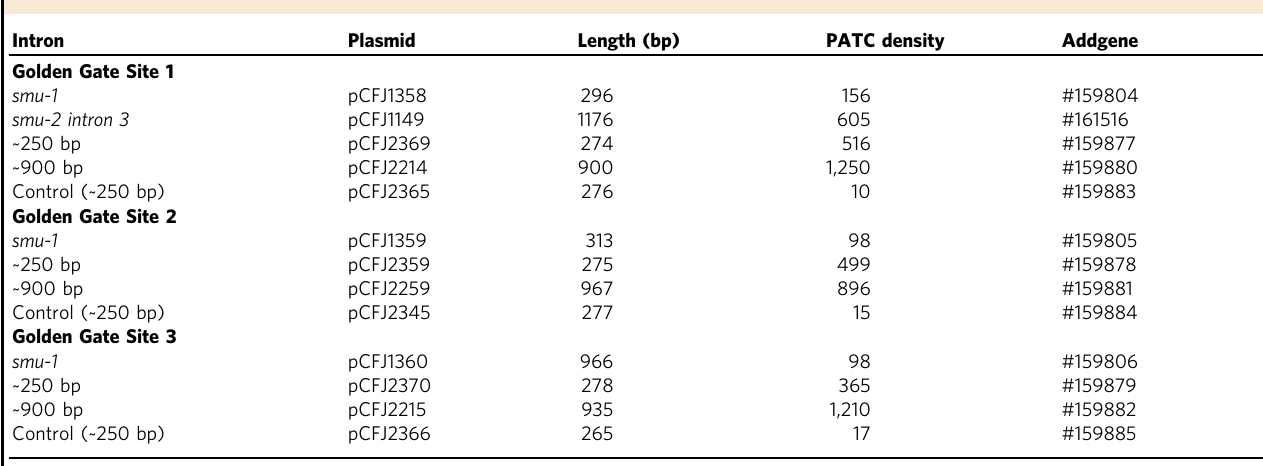
The PATC-score was calculated according to Fire et al.